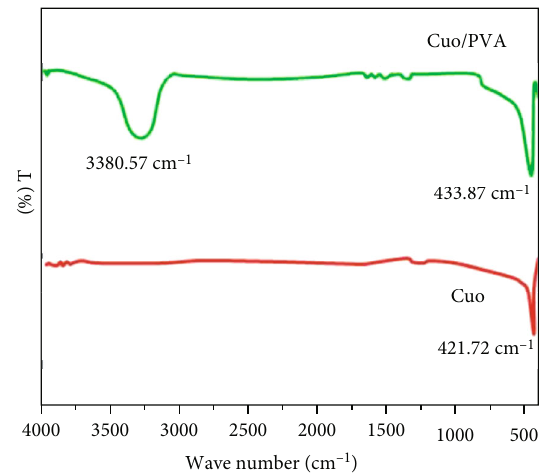
Figure 1: FT-IR spectrum of (a) CuO and (b) CuO/PVA